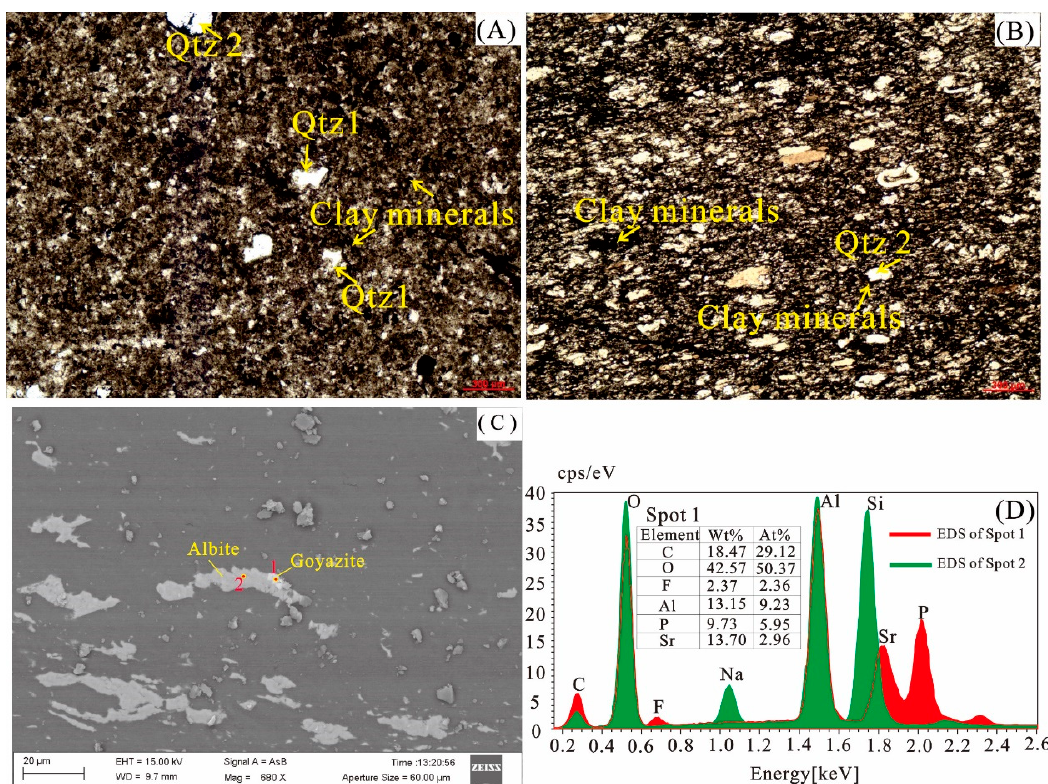
Figure 5. Characteristics of the mineral phases observed using a single-polar microscope ( A , B ) and SEM ( C , D ). ( A ) Quartz and clay minerals in sample DP5 -2 -1-r. ( B ) Clay minerals and quartz in sample DP5 -2 -7-p. ( C ) Albite and goyazite in sample DP5 -2 -2. ( D ) EDS spectrum of Spots 1 and 2. Qtz1, angular quartz; and Qtz2, rounded quartz.